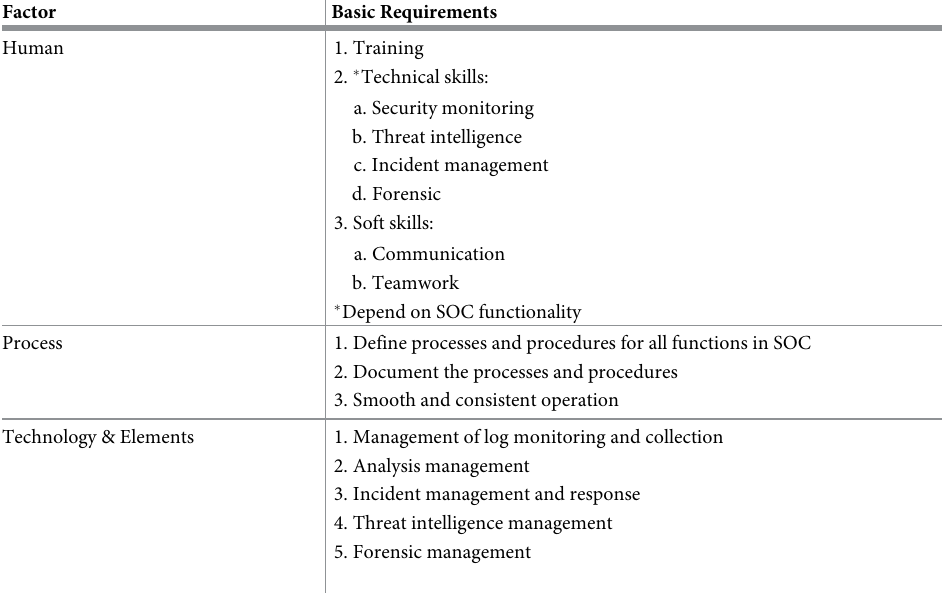
Table 20. Basic requirements for humans, processes, and